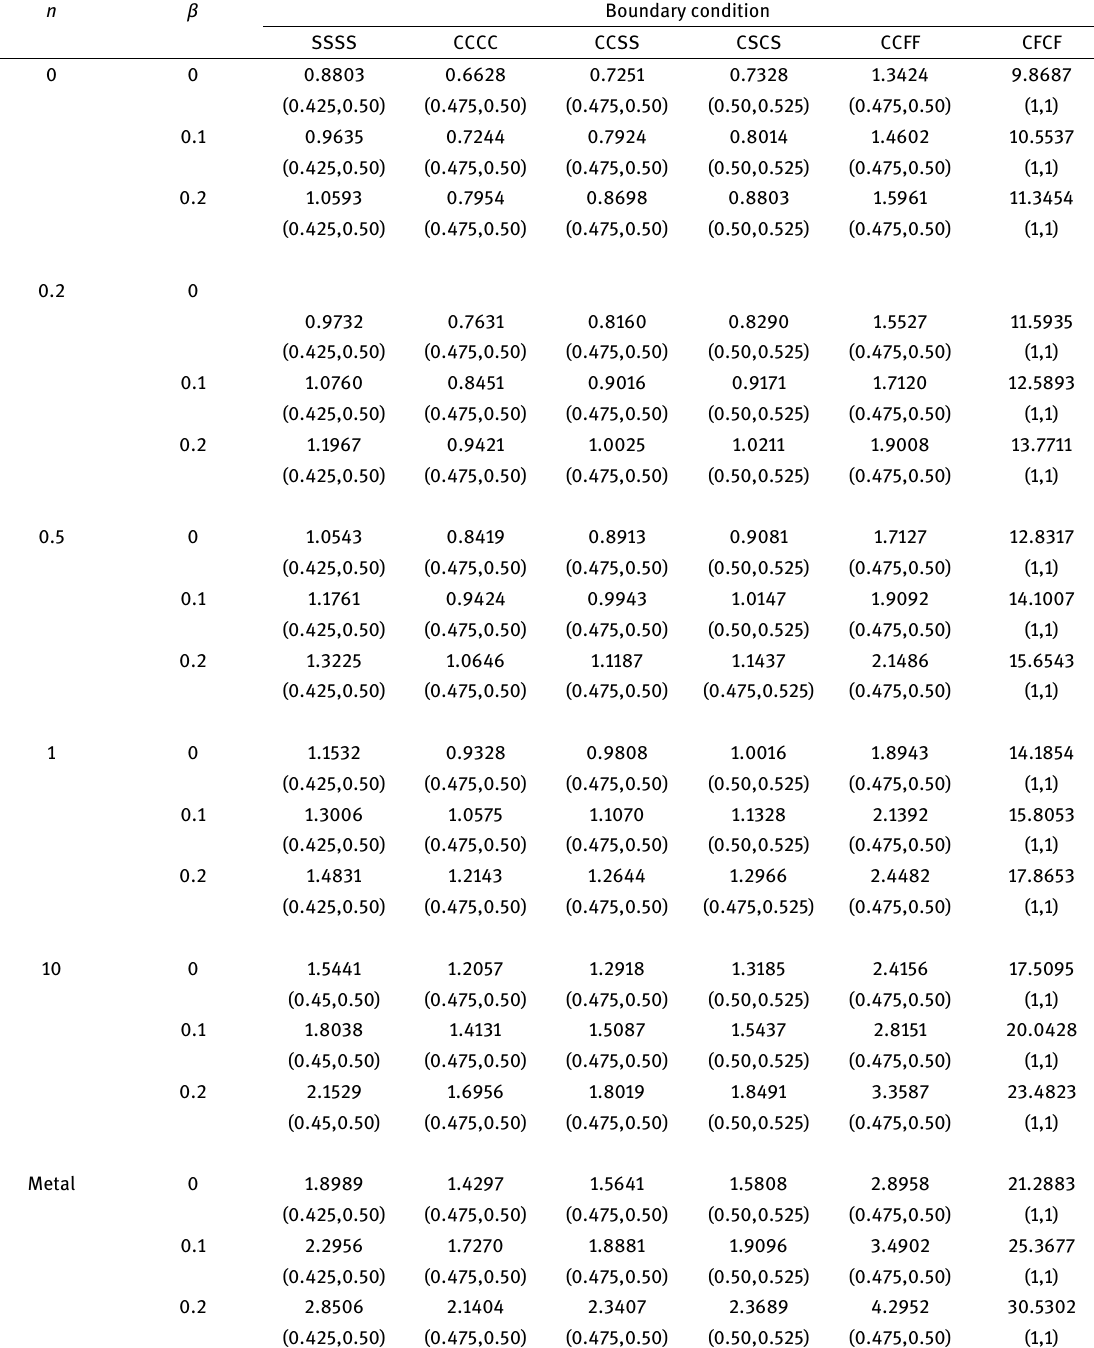
Table 4: Variation of non-dimensional deflection of FGM porous conoidal shell subjected to sin-sin loading.